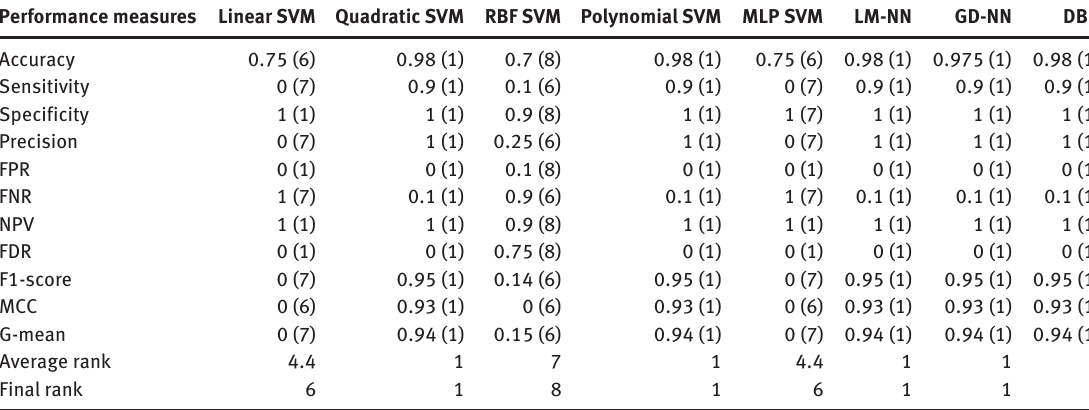
Table 1: Performance Analysis of Proposed and Conventional Fault Signal Recognition in Power Distribution System for Normal Signal.